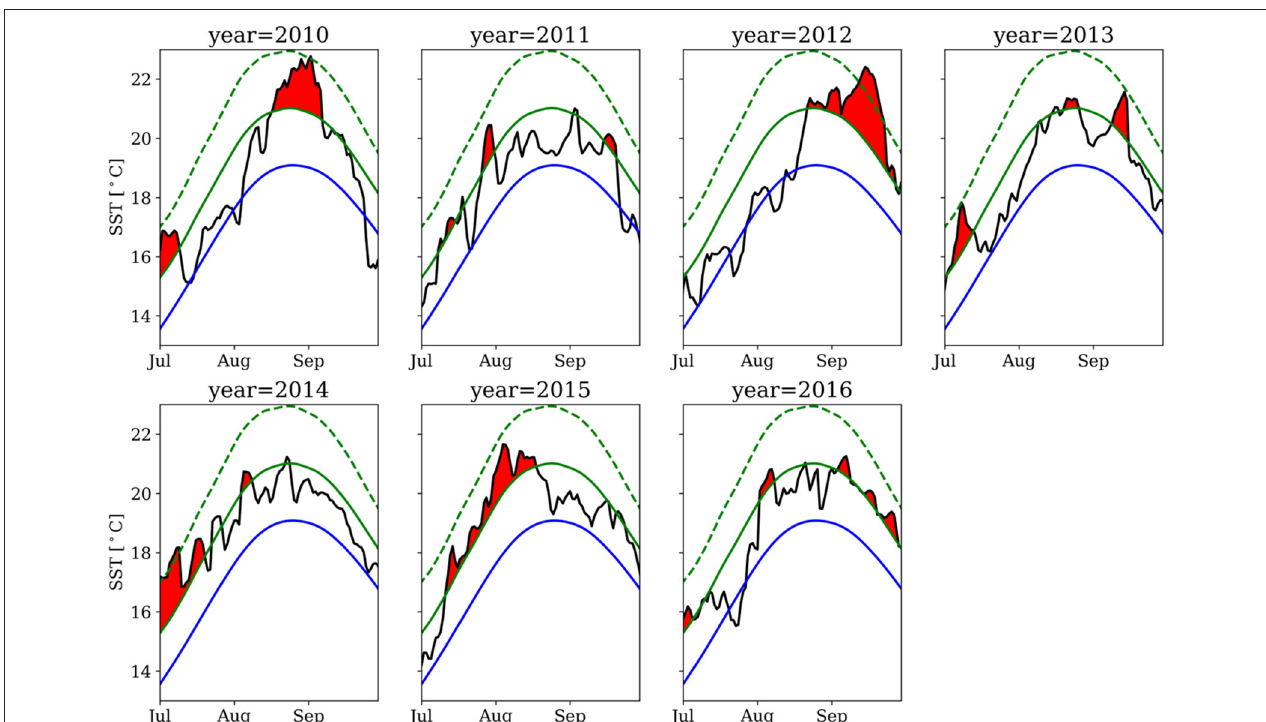
FIGURE 4 | The climatology (blue line), 90th percentile marine heatwave threshold (green solid line), and time series (black line) for SST ( ◦ C) averaged over the box (143–147 ◦ E 40–43 ◦ N). The red filled area indicates the period associated with the identified marine heatwaves. The green line is the twice of the 90th percentile difference from the mean climatology value for the defining Categories II events. Each panel shows time series in JAS of each year from 2010 to 2016.